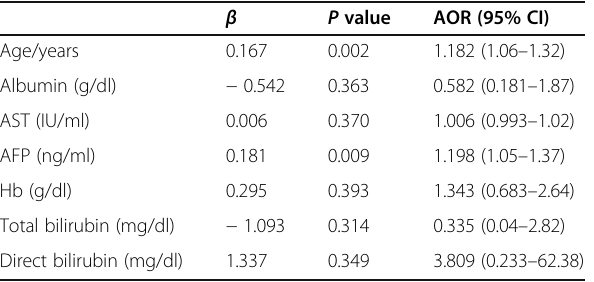
Table 7 Predictors of hepatocellular carcinoma among studied cases